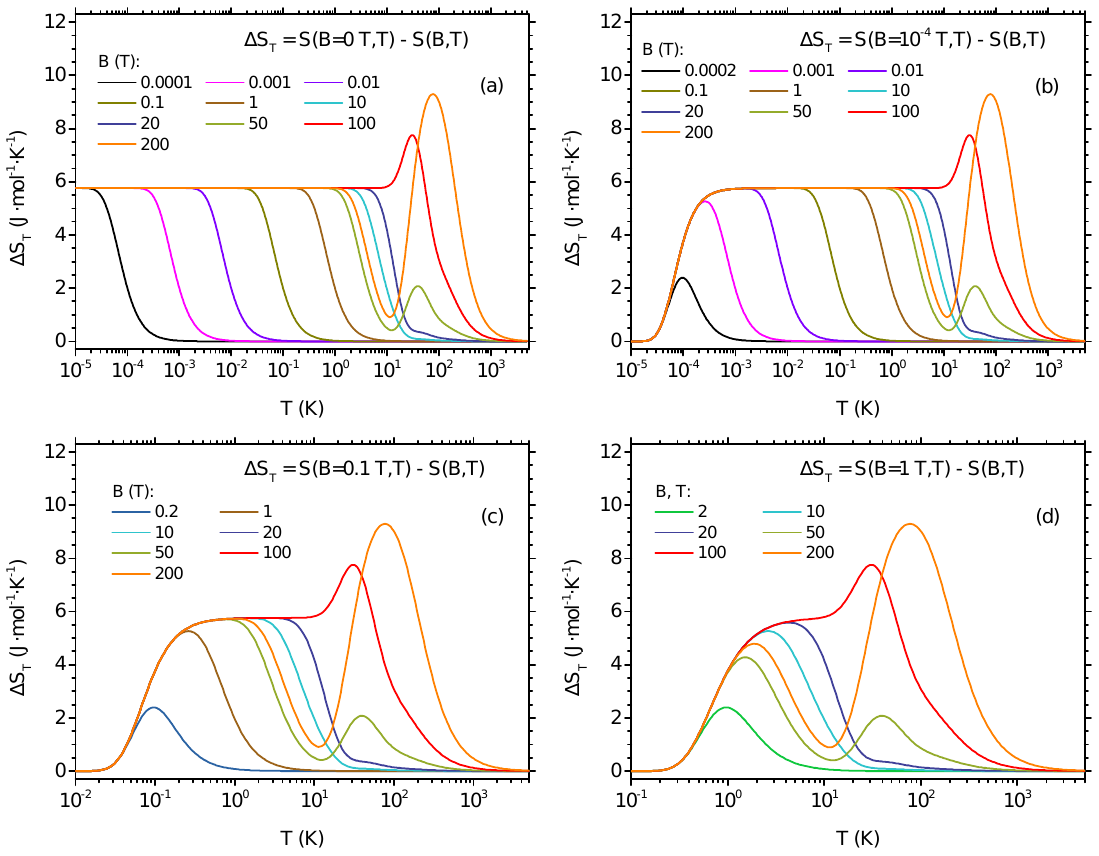
Figure 6. Isothermal entropy change as a function of temperature between the initial magnetic field and varying values of final magnetic field: ( a ) initial field of 0 T; ( b ) initial field of 10 − 4 T; ( c ) initial field of 0.1 T; and ( d ) initial field of 1